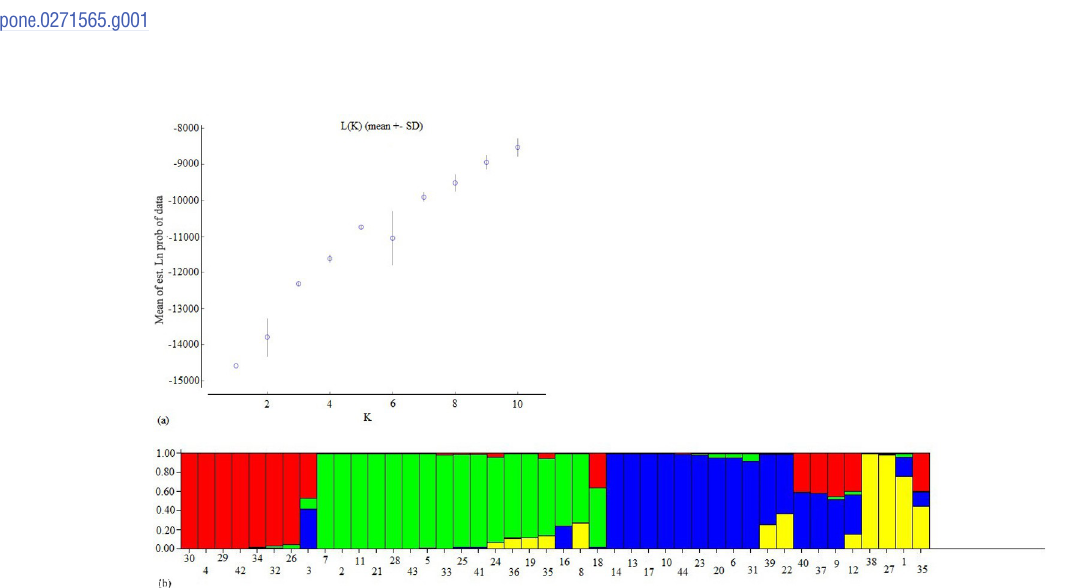
Fig 2. Estimated population structure of 44 pigeonpea genotypes. (a) Average of likelihood value L (K) (mean + SD) against probable number of clusters (K). (b) Barplot of subpopulations at K = 4. Each genotype is represented by a vertical bar and partitioned into colored segments which represent the estimated probability membership in each of the K-inferred clusters on the y-axis. Bar colors (red, green, blue and yellow) indicate the groups identified through the structure